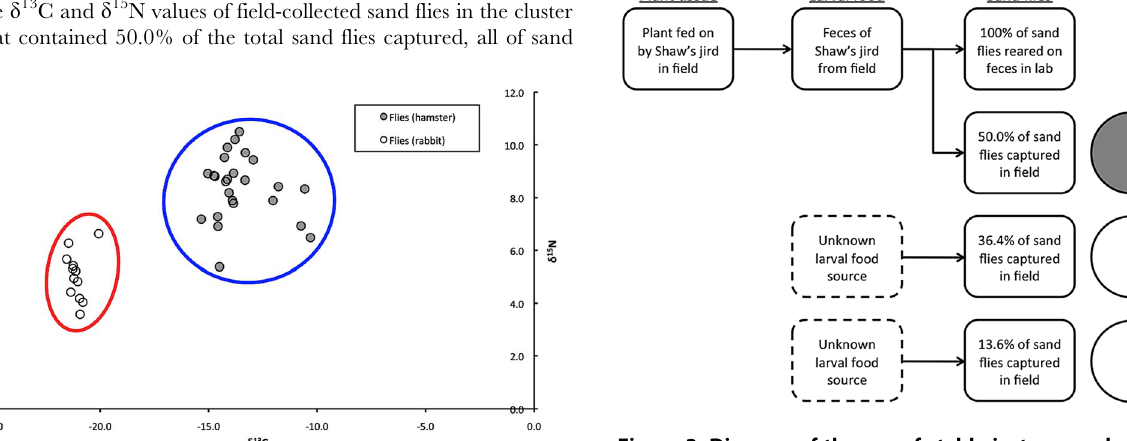
PLOS Neglected Tropical Diseases |